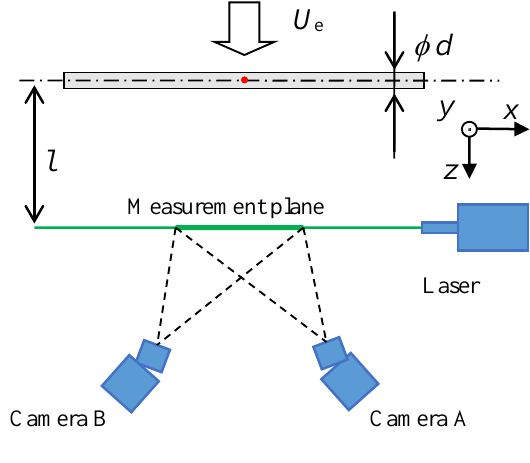
Fig. 1. Experimental setup